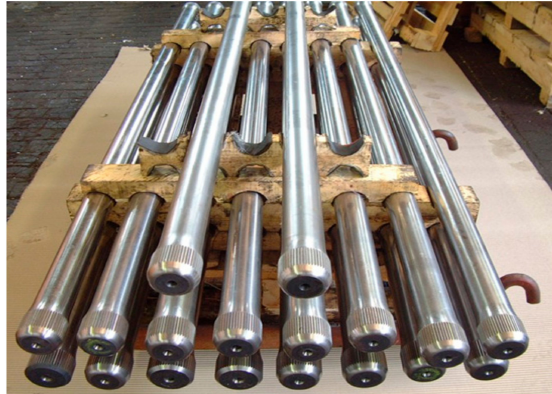
Figure 1. Set of torsion spring bars ready for delivery.